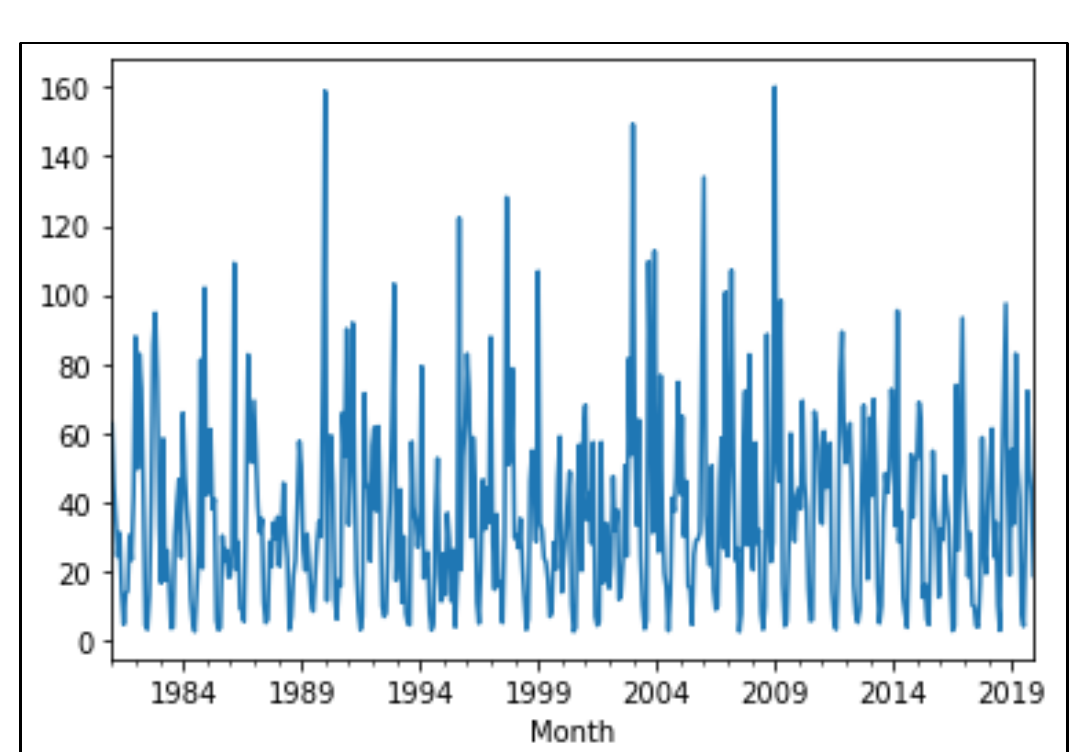
Figure 2. Historical monthly rainfall in the city of Zaghouan from 1981 to 2019.